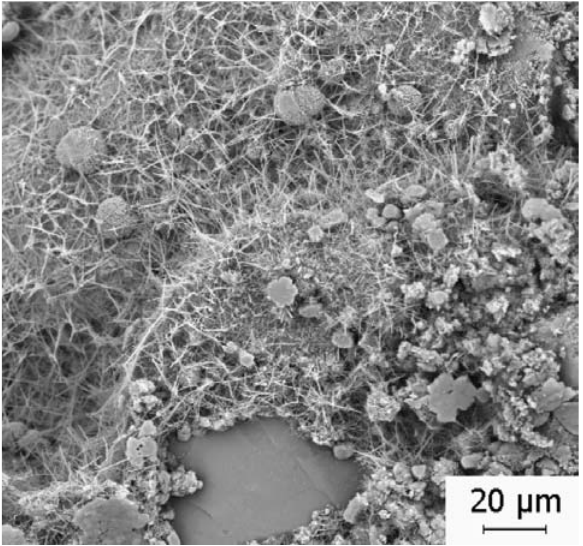
Figure 9. SEM micrograph of the anhydrite crystals in sample (K) (CPII-Z-32 cement/10% bottom ash/sand) after 28 days of aging.